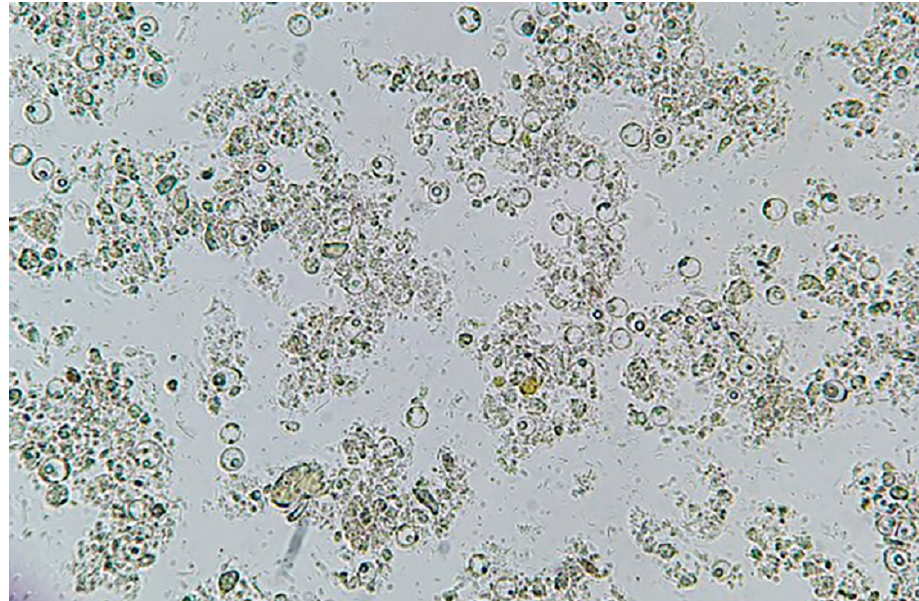
Figure 1. Microscope field image (100× g magnification) obtained in a sample from an infected Blastocystis patient with high parasite